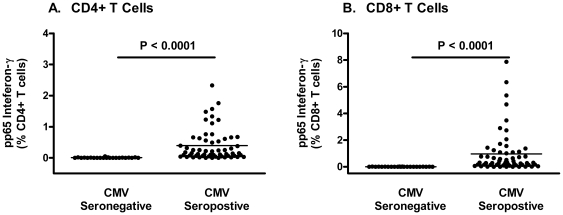
The distribution of percent of CMV-specific T cells in CMV-seronegative and CMV-seropositive, HIV-uninfected subjects.